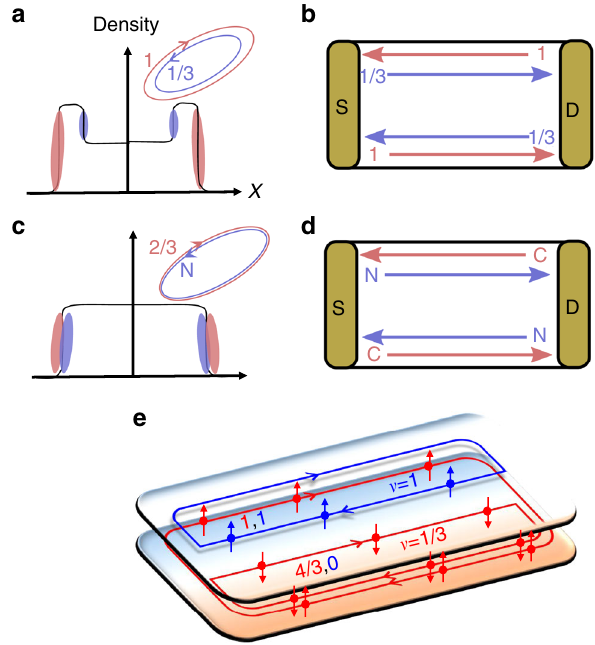
Fig. 1 The 2/3 hole-conjugate state and its synthetized form. a The unequilibrated v = 2/3 state; composed of two counter-propagating chiral modes: a downstream v = 1 mode and an upstream v = 1/3 Laughlin excitation mode. Red and blue represent electron density pro fi le of independent v = 1 and v = 1/3 modes at the edges, respectively.